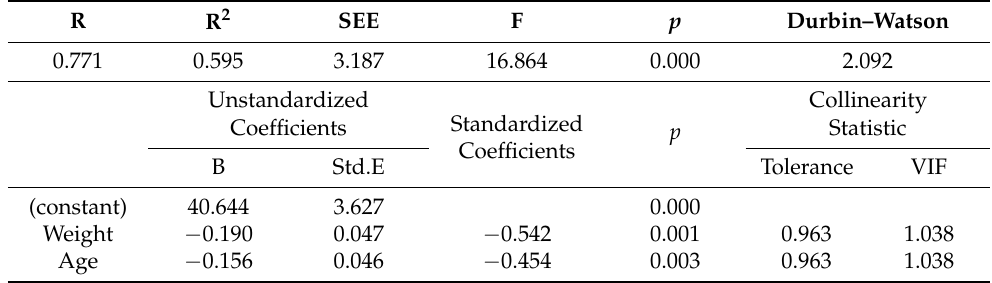
Table 2. Multiple linear regression analysis to estimate arm ergometer VO 2 max based on anthropo- metric